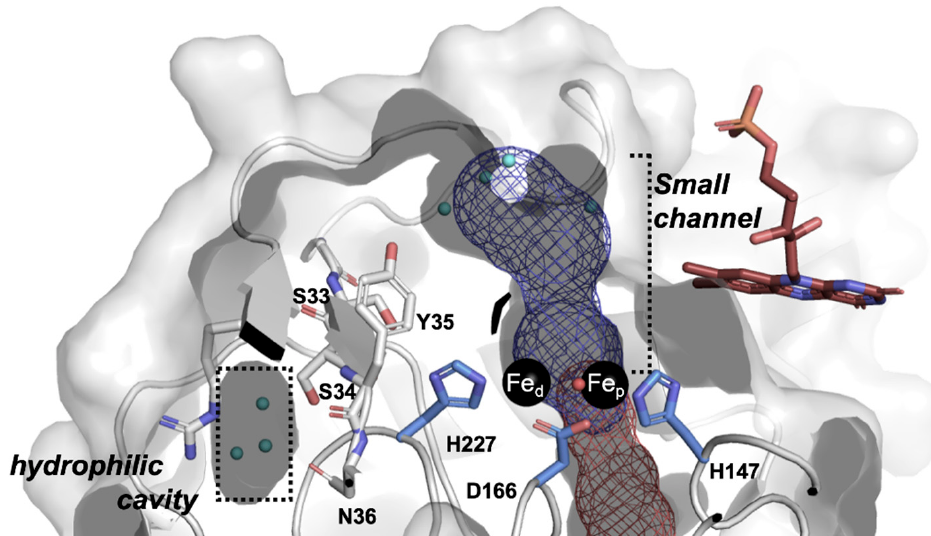
Figure 2. The motif -GSSYN- in E. coli FDP. The protein structure is presented as cartoon together with its external surface. The small channel is presented as blue mesh and part of the large channel in red mesh, determined using MOLE [28]. The color code of the amino acid residues and the iron atoms are the same as in Figure 1. A hydrophilic cavity close to the motif -GSSYN- is also presented. The water molecules in this cavity and at the entrance of the small channel are depicted in cyan.